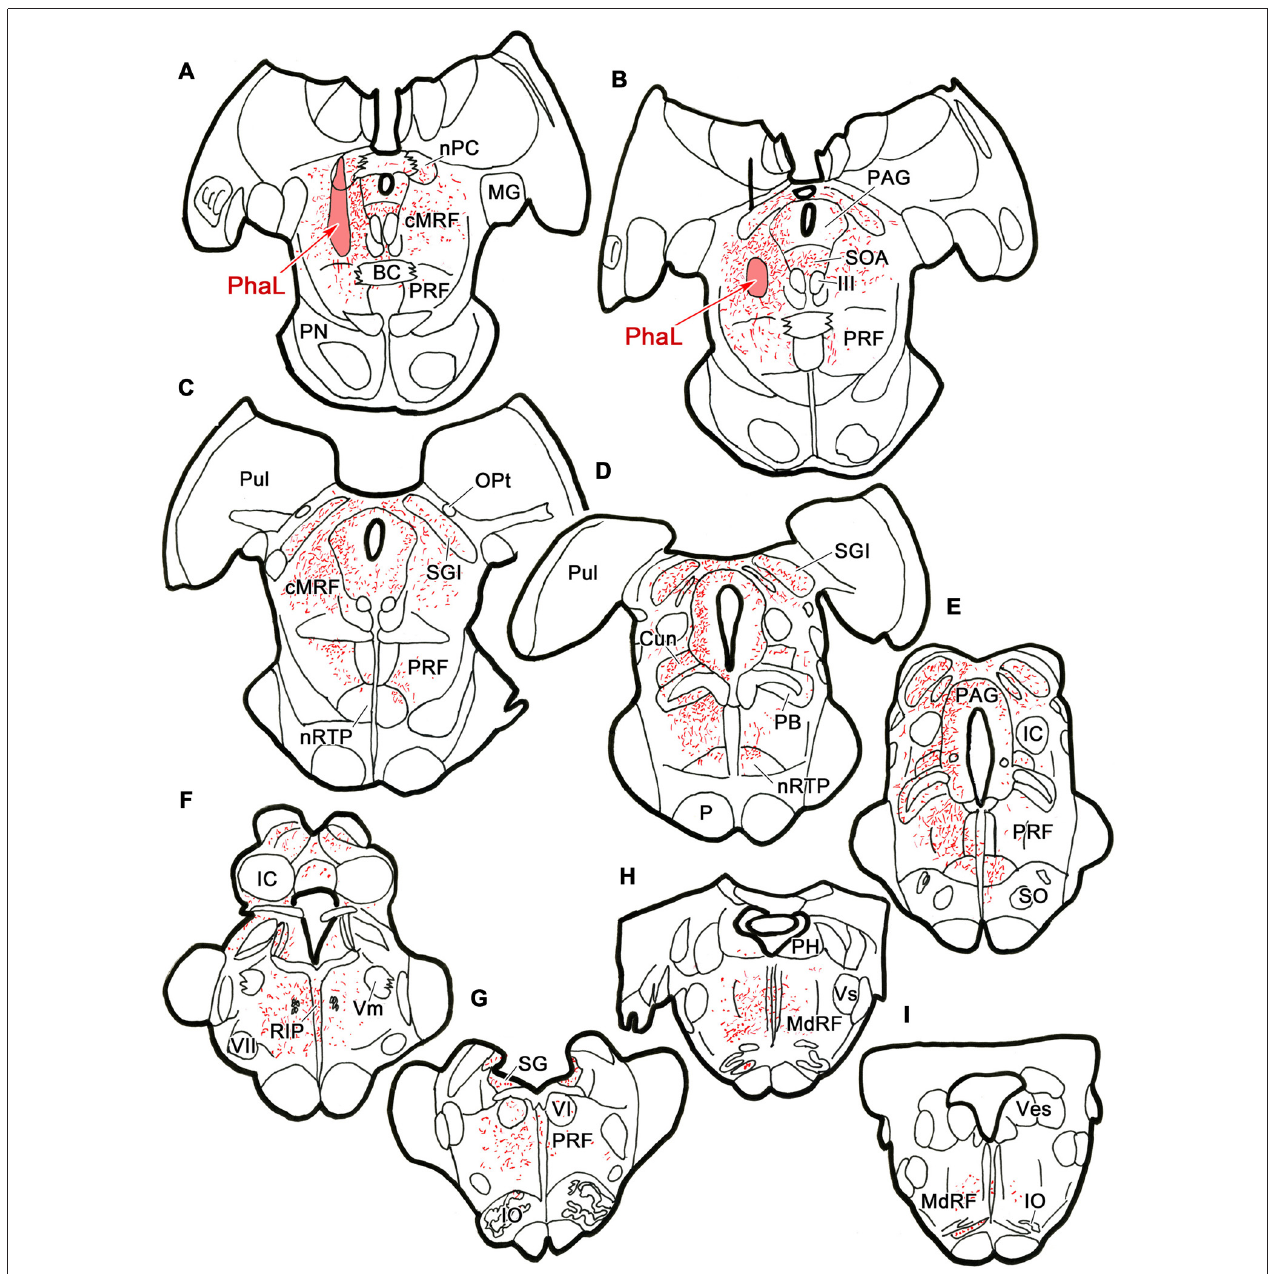
FIGURE 4 | Distribution of cMRF terminals labeled by Phaseolus vulgaris leucoagglutinin (PhaL). The distribution of labeled terminals (stipple) and axons (lines) observed following a PhaL injection into the cMRF (A,B) is charted on a rostral to caudal series of sections through the midbrain (A–F) , pons (A–G) and medulla (H–I)